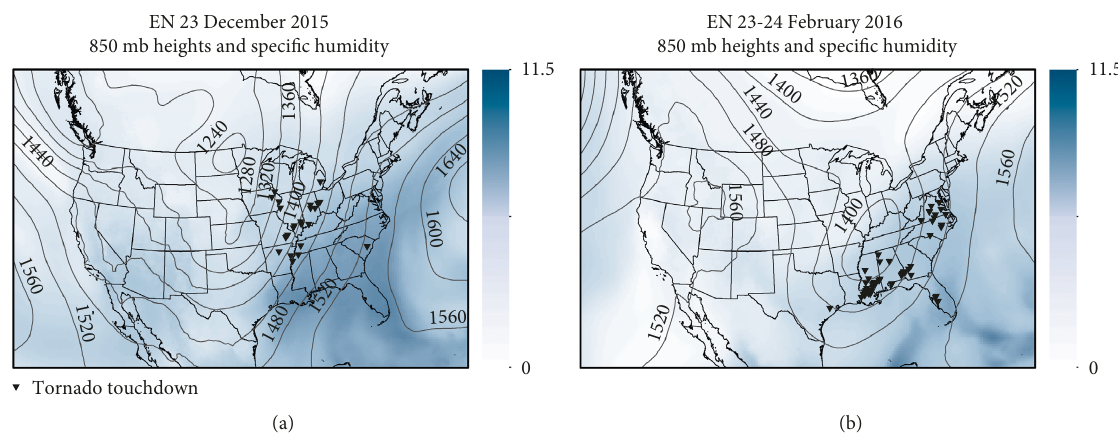
1 )) on (a) 23 December 2015 and (b) 23-24 kg · −